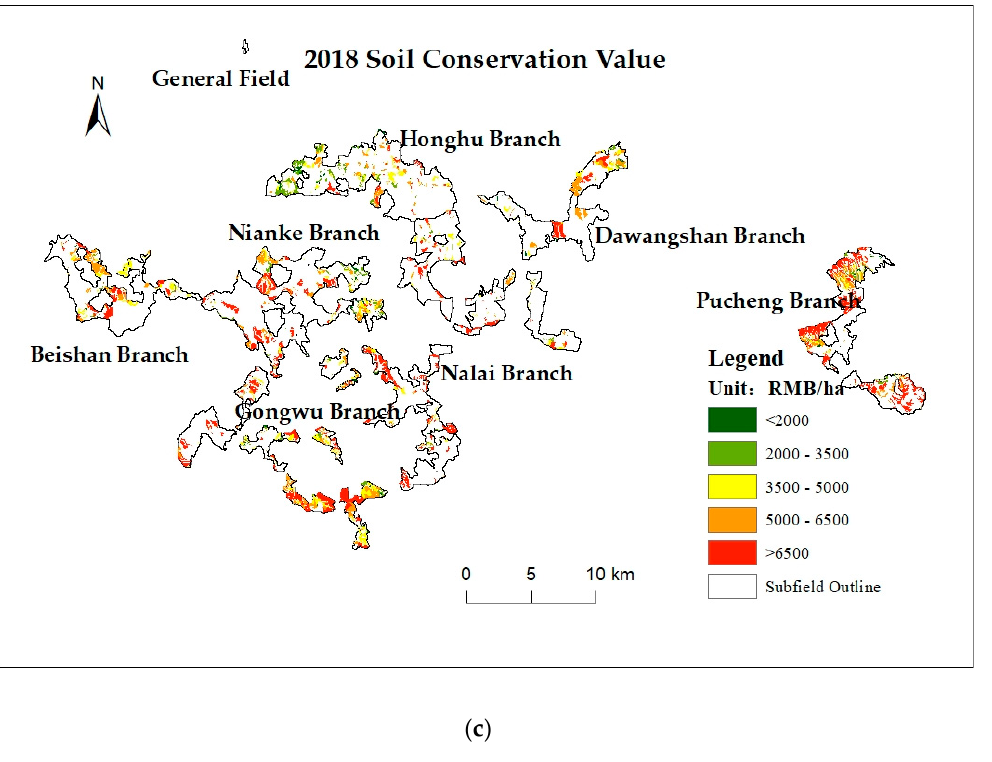
Figure 4. Spatial distribution of the soil conservation values of PM plantations of the northern tropical case study area in 2009–2018. ( a ) 2008 Soil conservation value; ( b ) 2013 Soil conservation value; ( c ) 2018 Soil conservation value.